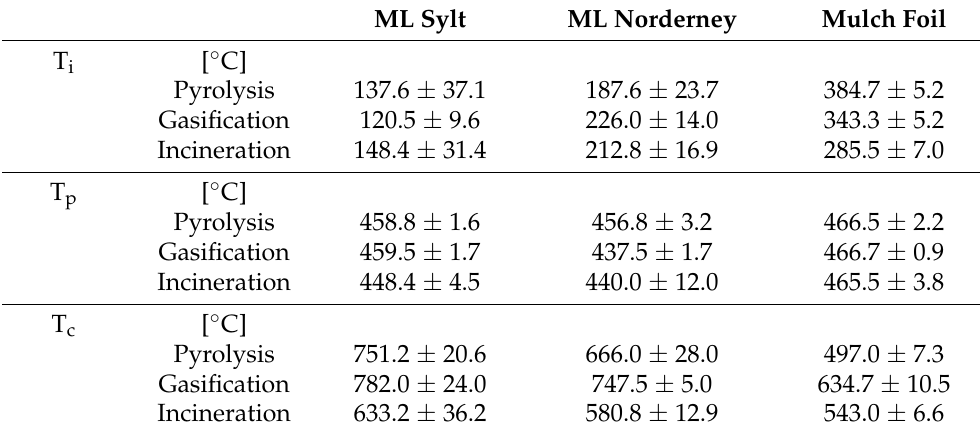
Table 5. Overview of the specific reaction temperatures and calculated standard deviation. T i indicates the initial temperature when 1 wt% mass loss is quantified while T c shows the end of the reaction and a 99 wt% mass constancy. T p marks the temperature of the highest relative mass loss as calculated by the derivation of the TGA signal.